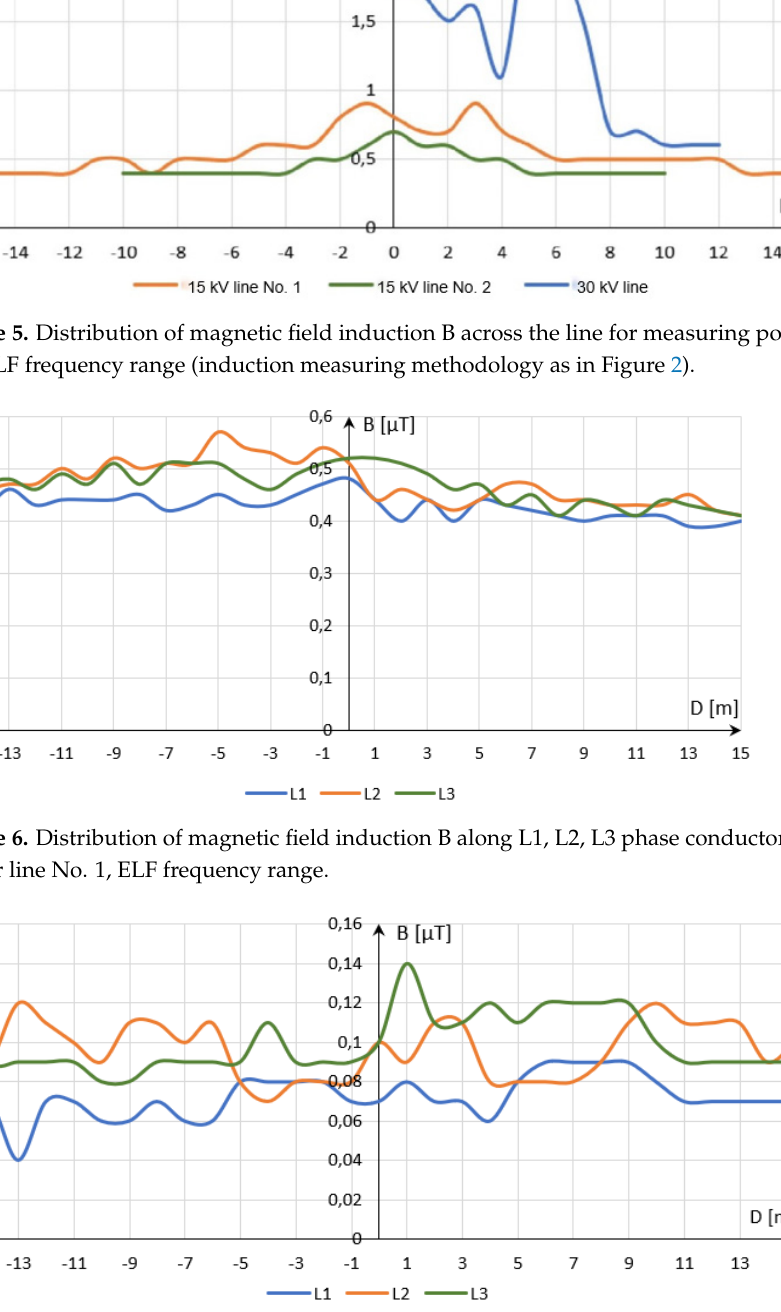
Figure 5. Distribution of magnetic field induction B across the line for measuring point No. 2, and the VLF frequency range (induction measuring methodology as in Figure 2).